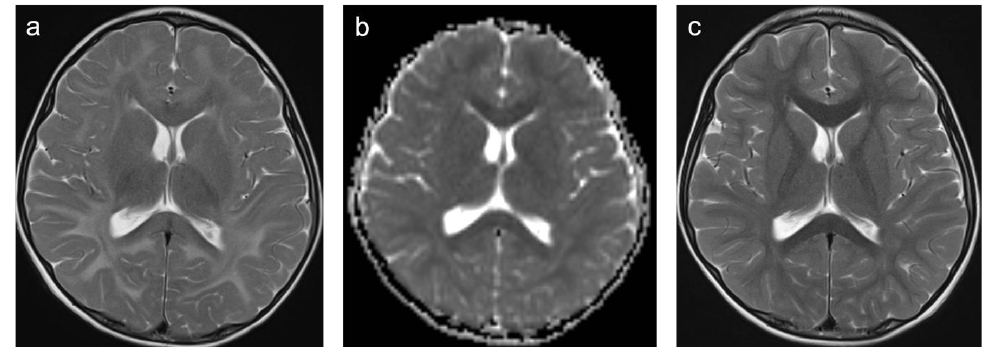
Figure 9. Representative case “Inborn errors of metabolism”: methionine adenosyltransferase I/III deficiency. T2W ( a , c ) sequences and ADC map ( b ). Three-year-old boy diagnosed with a methionine adenosyltransferase I/III deficiency. MRI shows T2W signal hyperintensities in subcortical and deep white matter with relative sparing of corticospinal tracts, corpus callosum and optic radiations ( a ). ADC map demonstrates decreased ADC value of the lesion ( b ). Normalization of established WMSAs within two years on a strict methionine-restricted diet ( c ).